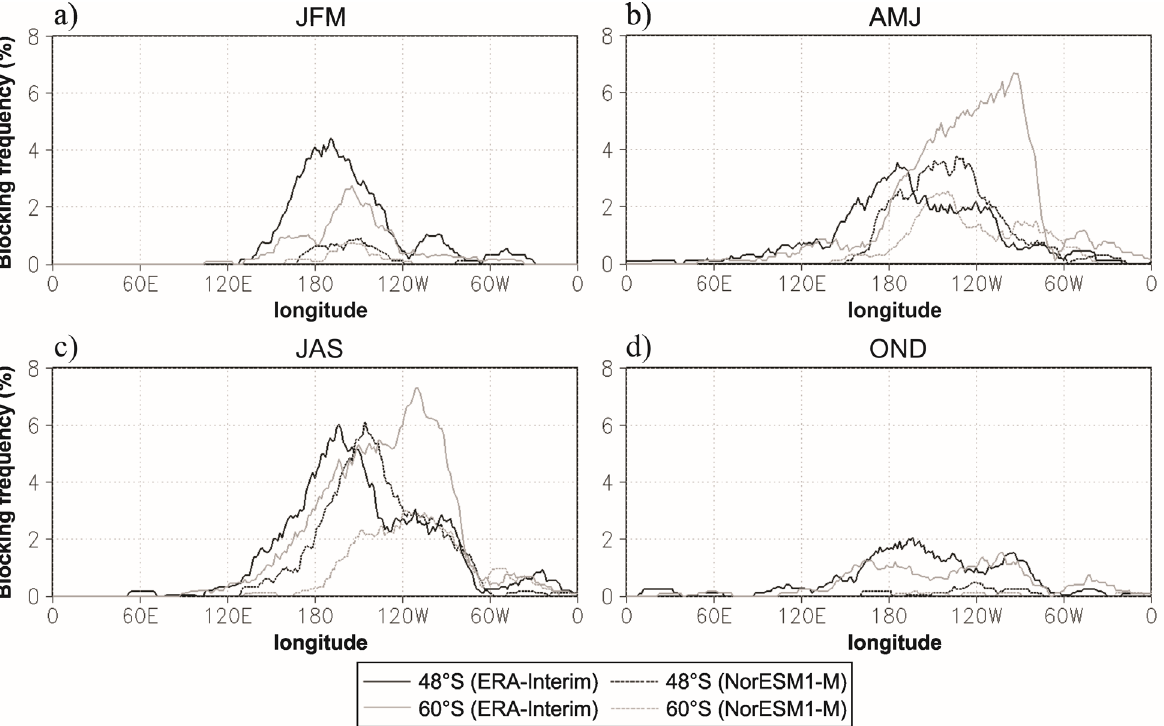
Figure 6. Seasonal frequency of blocking events by longitude (%) in the ERA-Interim reanalysis (continuous lines) and in the NorESM1-M historical experiment (dashed lines) during (a) summer (JFM), (b) autumn (AMJ), (c) winter (JAS) and (d) spring (OND) over